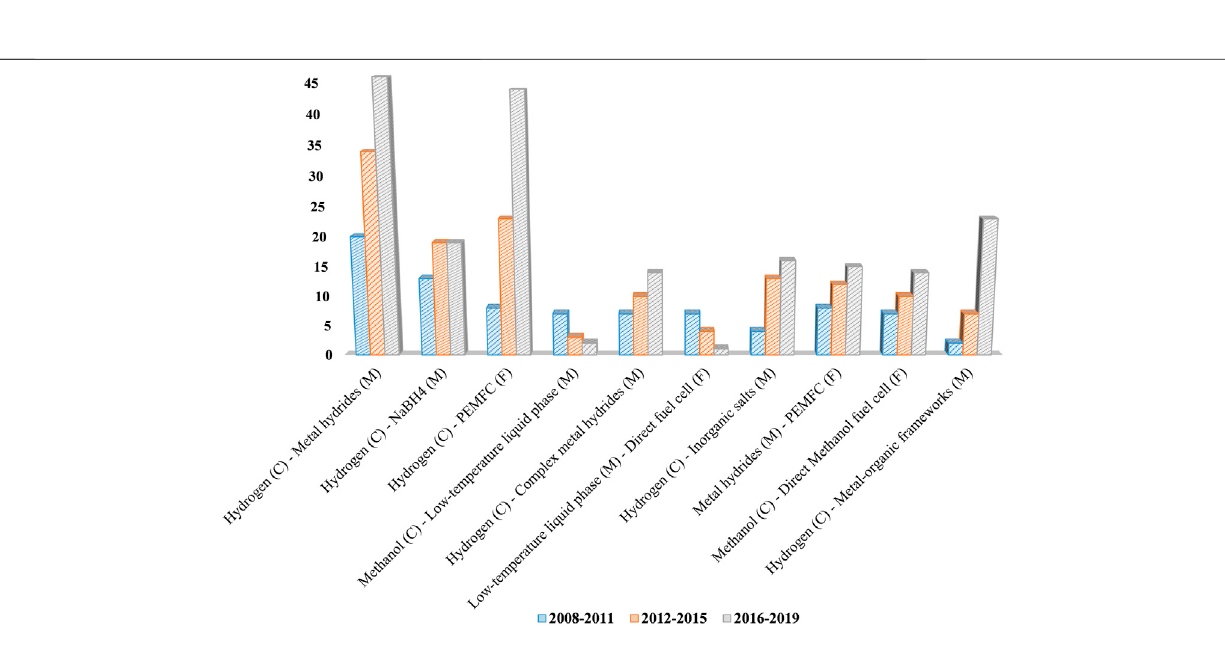
Frontiers in Energy Research |